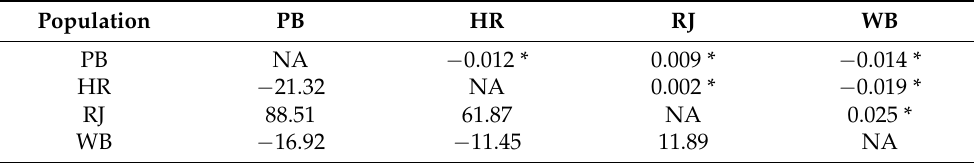
Table 7. Pair-wise Fst (above diagonal) and Nm (below diagonal) of F. graminareum populations from four states of northern plains of India.